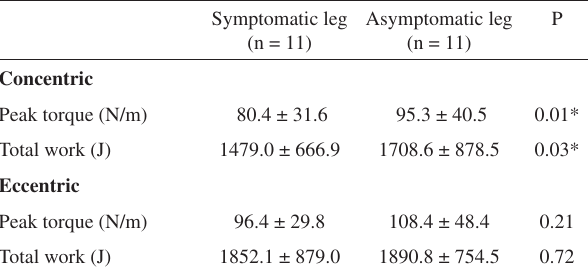
Table 2 - Concentric and eccentric peak torque and total work in symptomatic and asymptomatic legs in patients with unilateral intermittent